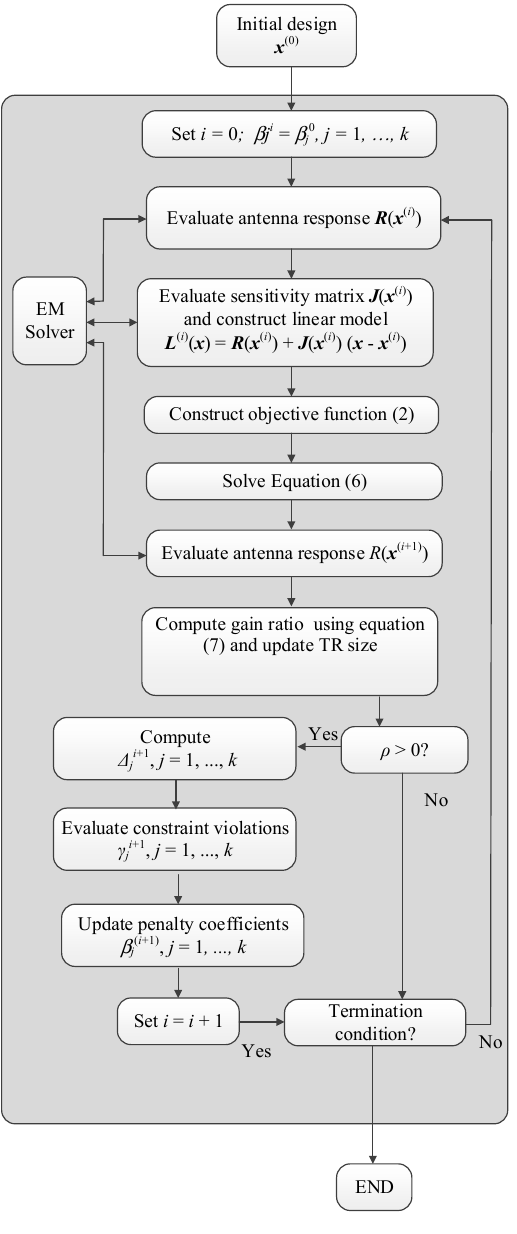
Figure 3. Operational flow of the proposed size-reduction algorithm with automated adjustment of penalty factors.